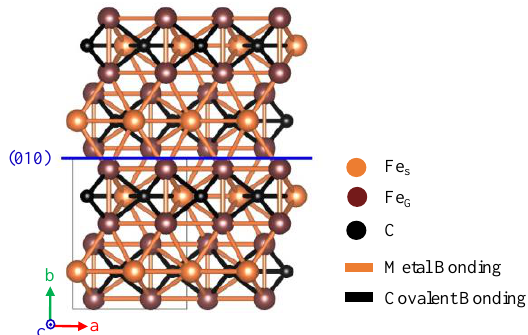
Figure 9. Schematic illustration of cementite observed from [001], where black and orange lines show that a type of bonding between atoms are covalent and metallic bonding, respectively.